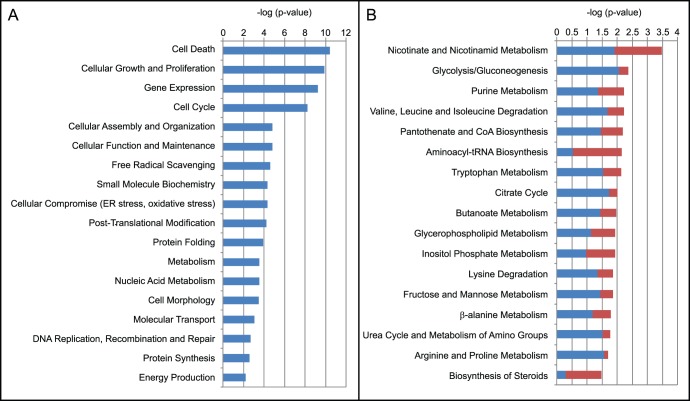
Ingenuity Pathway analysis (IPA) of differentially expressed genes.Relevant and significant (p<0.05, right-tailed Fisher’s exact test) (A) biological functions and (B) metabolic pathways identified using IPA. Red and blue colours represent the percentage of up- and downregulated genes. The function metabolism summarises carbohydrate, lipid, amino acid, vitamin and mineral metabolism. The complete list of functions and pathways can be found in Table S5.